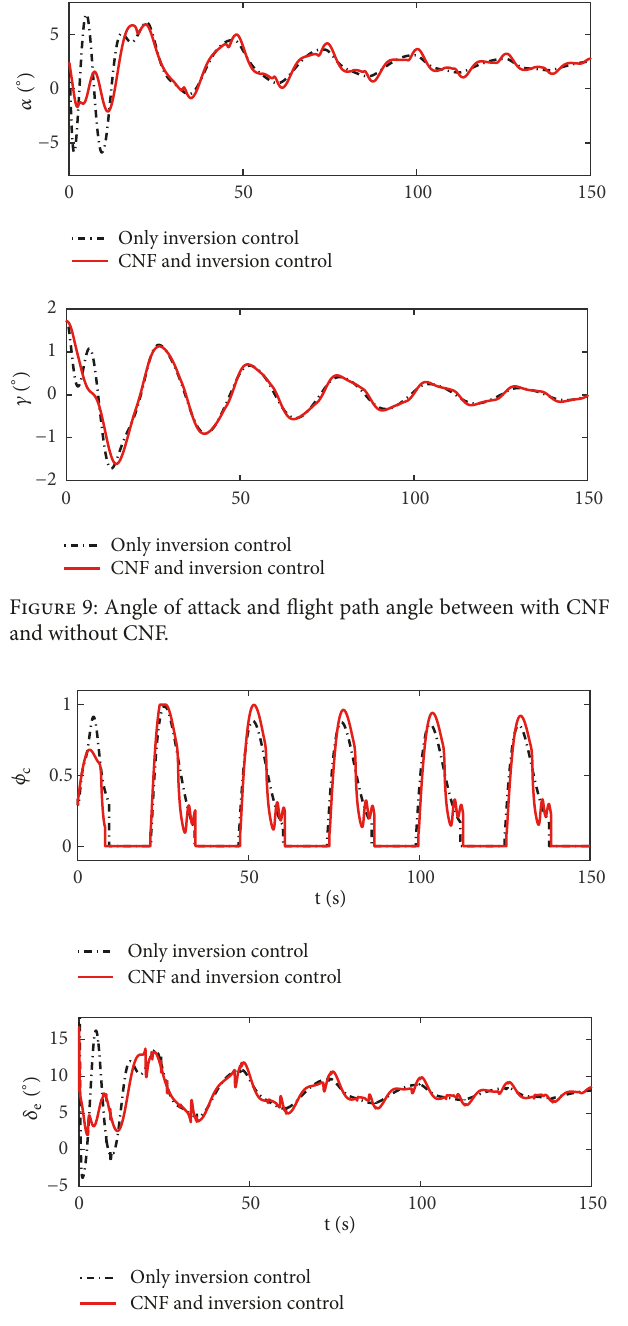
Figure 10: Control inputs between with CNF and without CNF.